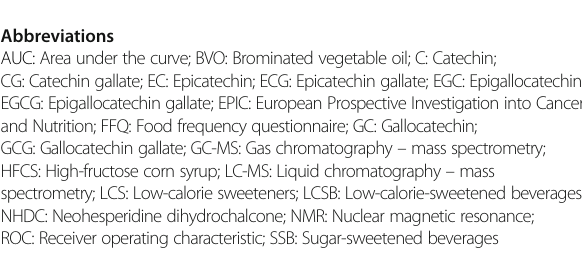
Additional file 1: Figure S1. Flow chart of literature search and screening for papers on biomarkers for non-alcoholic beverages. A, cof- fee; B, tea; C, low-calorie-sweetened beverages. (DOCX 134 kb) Additional file 2: Table S1. Low-calorie sweeteners approved for use in the European Union. (DOCX 16 kb) Abbreviations AUC: Area under the curve; BVO: Brominated vegetable oil; C: Catechin; CG: Catechin gallate; EC: Epicatechin; ECG: Epicatechin gallate; EGC: